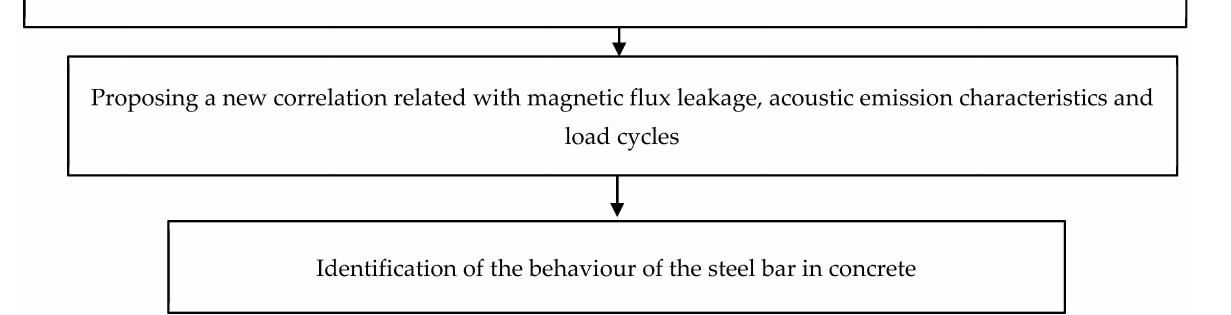
Figure 1. Process flow for evaluation of the steel bar behaviour in concrete